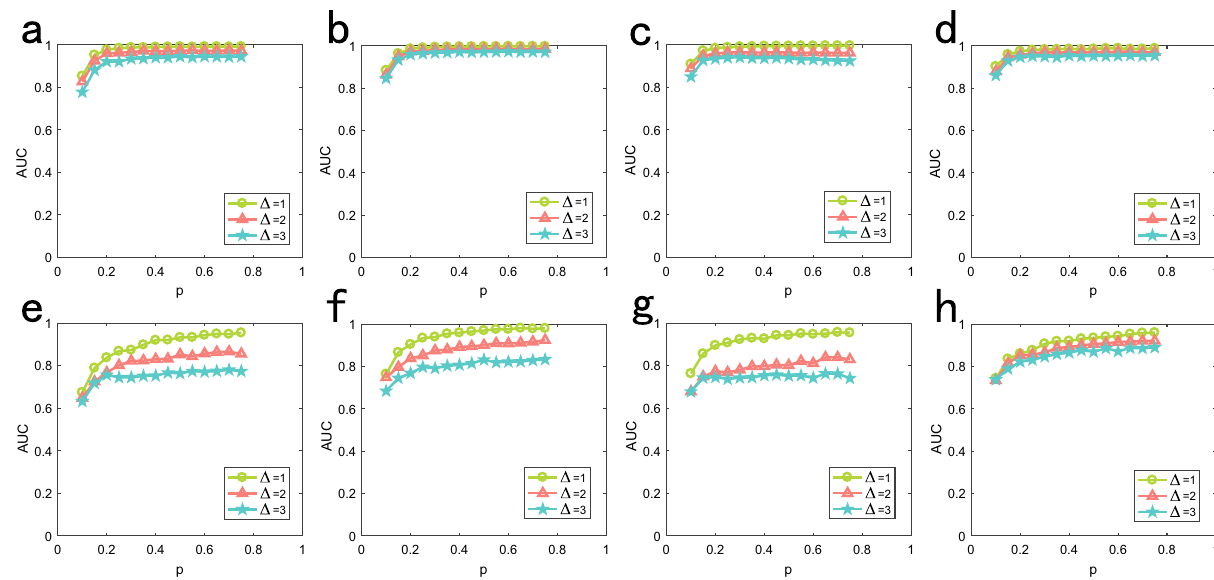
Figure 7. Performance of sources location with different initial time. We set the number of sources as 2, curves of different colors corresponding to different initial time difference between two sources. ( a )–( d ) are Diffusion dynamics on BA, ER, Football and Santa Fe respectively. ( e )–( h ) are SI